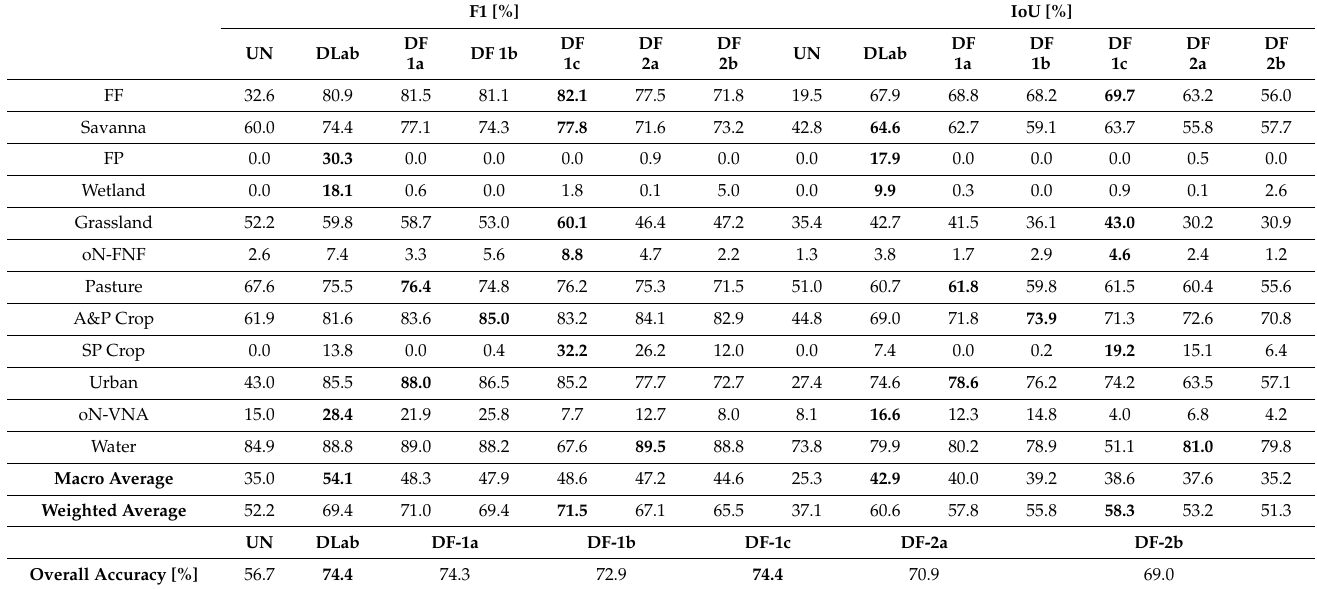
Table 4. Test accuracies of the classifications based on multi-modal data (S1TsS2_12 dataset) for SotA and DeepForest models. Abbreviations: DF = DeepForest, DLab = DeepLab, FF = forest formation, FP = forest plantation, A&P Crop = annual and perennial crop, oN-FNF = other non-forest